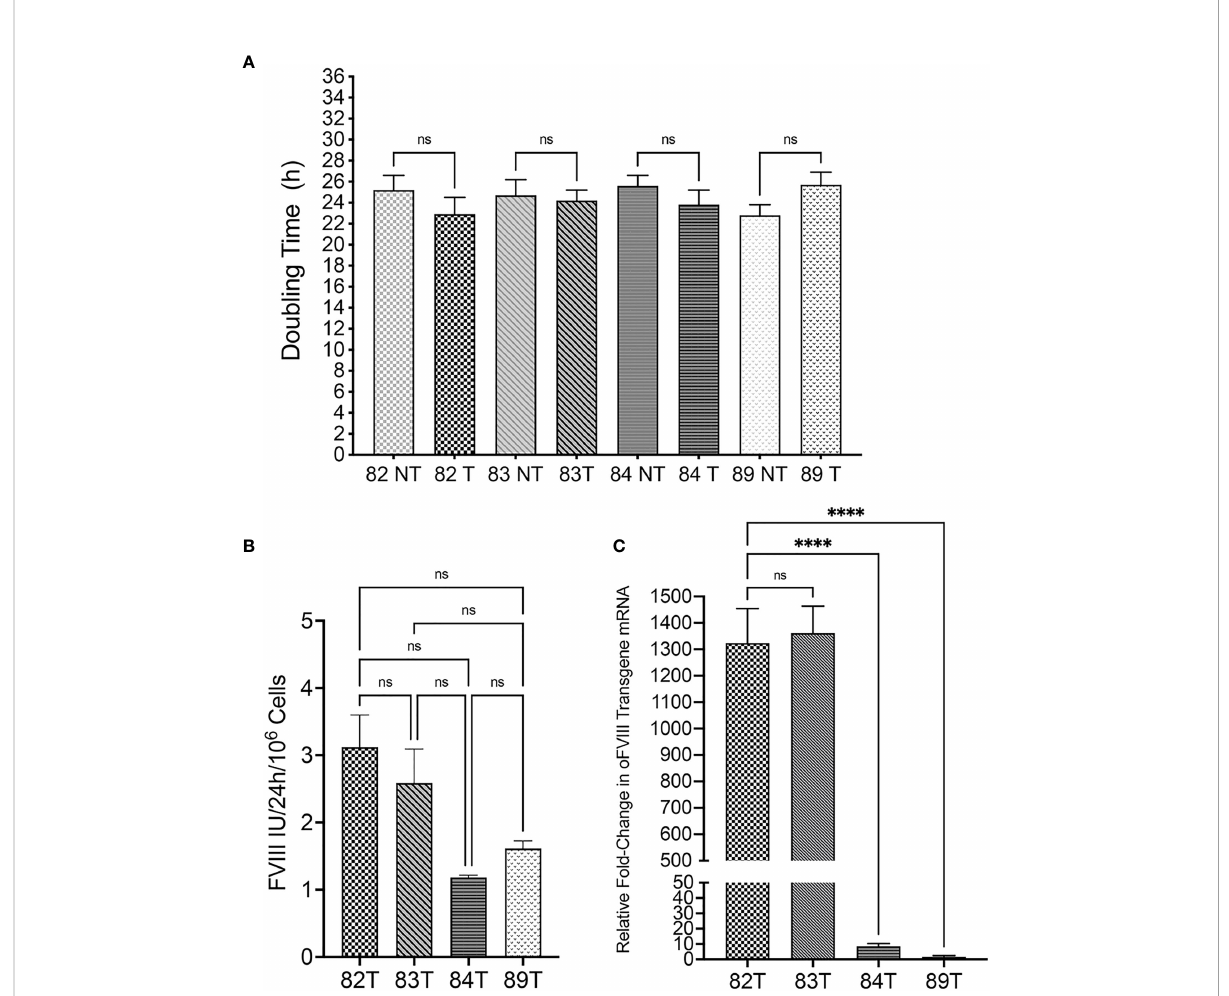
FIGURE 2 Evaluation of Transduced Sheep Bone Marrow-Derived MSCs. (A) Transduction did not exert a statistically signi fi cant effect on cell doubling time (n=4 biologic replicates; n=4 technical replicates; p > 0.05). (B) FVIII activity in the supernatant of transduced cells was measured by one stage assay (aPTT) to determine the amount of oFVIII protein secreted by each MSCs population; levels of FVIII production differed markedly between the 4 individual sheep, but differences did not reach statistical signi fi cance (n=4 biologic replicates; n=3 technical replicates; p > 0.05). (C) RT- qPCR quantifying the expression of oFVIII mRNA showed a signi fi cant increase in the levels of oFVIII mRNA after transduction, with over a 1000- fold increase in the two MSCs lines that had higher levels of FVIII secretion, but more modest increases in the other two cell lines (n=4 biologic replicates; n=3 technical replicates; ****p < 0.0001). ns, not signi fi